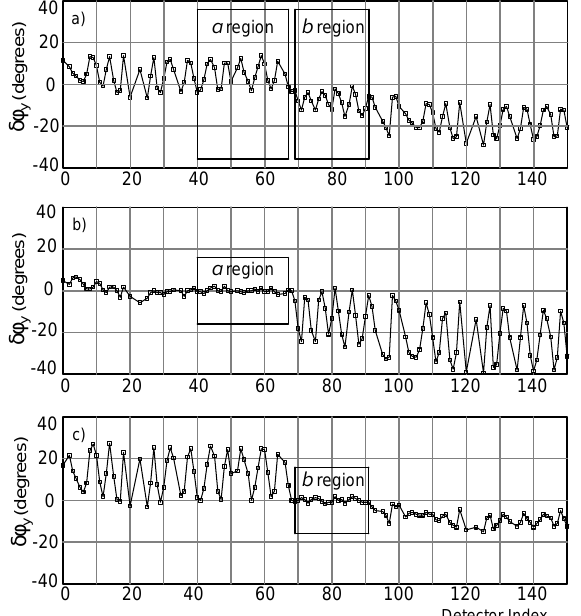
FIG. 3. Analysis of vertical phase data. df is the difference between the measured and theoretical design phase. (a) df as obtained from a measurement, (b) df with the fit from the a region subtracted off, (c) df with the fit from the b region subtracted off. The boxes shown in the figures correspond to the fit